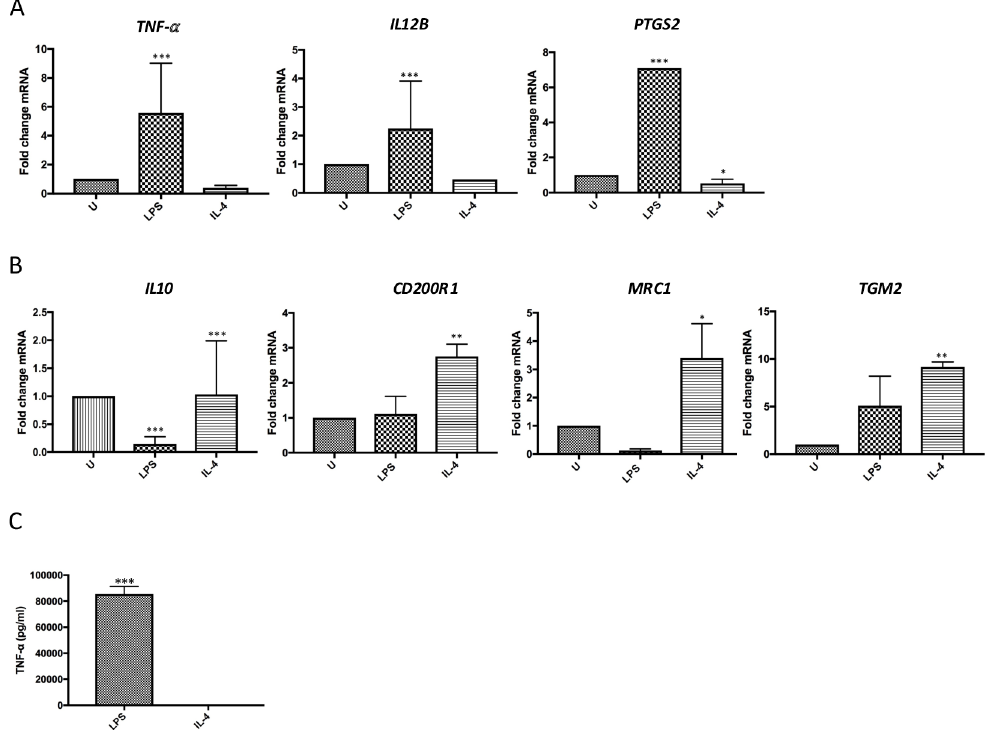
Fig 3. Expression of M1 & M2 markersin M1 and M2 MDM compared to untreated MDM. Expression of M1 & M2 markers relative to untreated healthy humanperipheral blood MDM (U) in MDM treated with